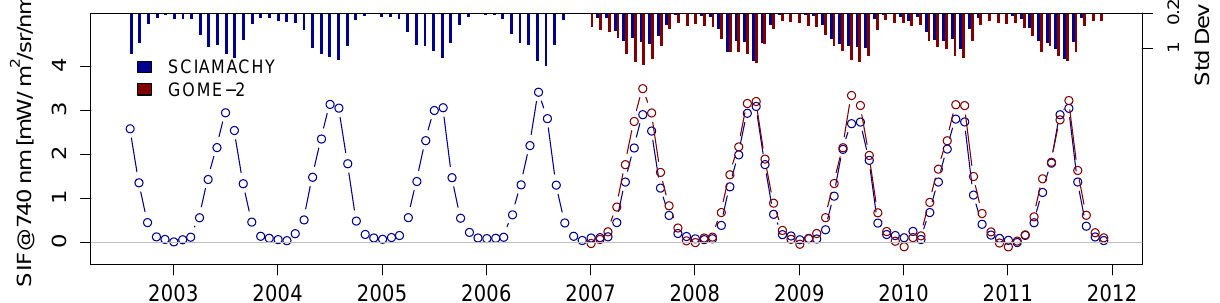
Figure 12. Comparison of monthly SIF averages derived from SCIAMACHY (blue) and GOME-2 (red) for croplands between 100–80 ◦ W, 35–50 ◦ N (shown in Fig. 16). The standard deviation per time step is depicted as a bar plot.